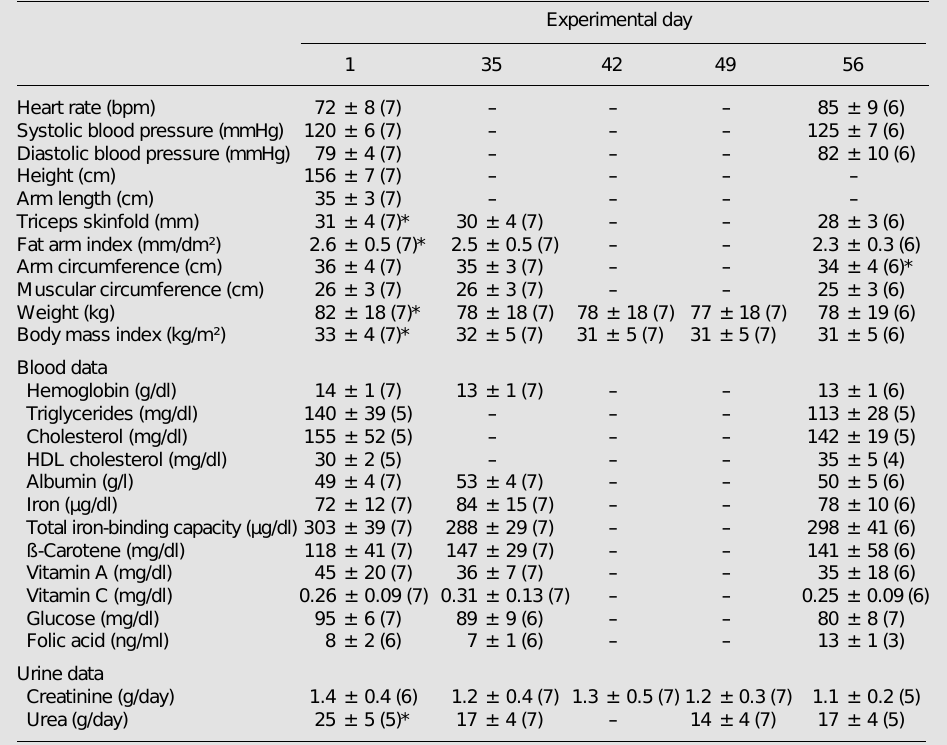
Table 1. Clinical, anthropometric and biochemical data of the volunteers throughout the experimental protocol.